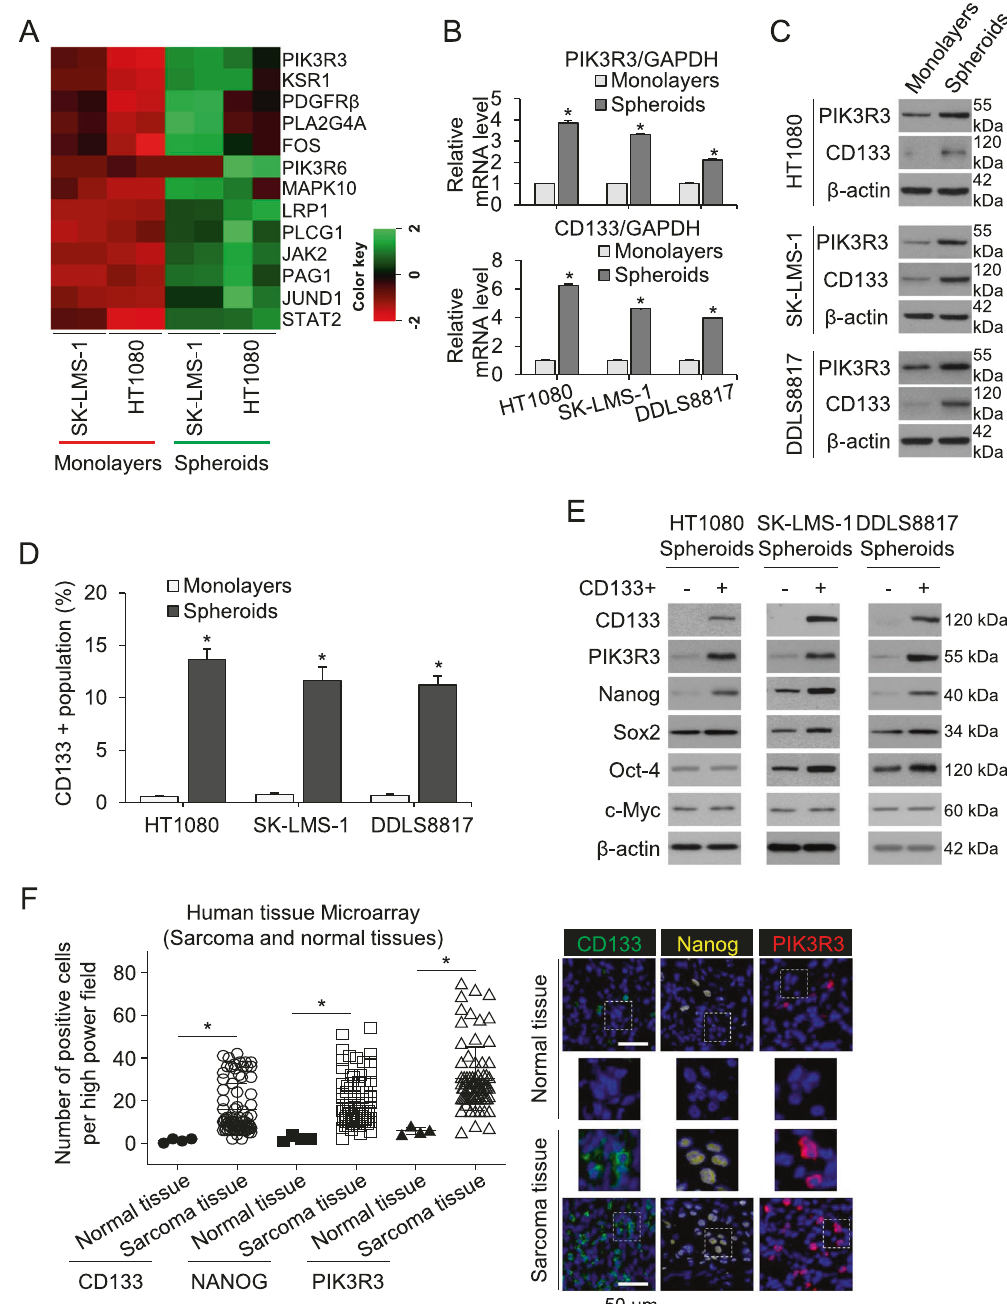
Fig. 1 PIK3R3 and Nanog are upregulated in sarcoma CSCs and human sarcomas. A Heat map of expression of survival signaling-related genes in two sarcoma cell lines cultured as spheroids vs. monolayers as measured by RNA sequencing. Each sample was run in duplicate. Real- time RT-PCR ( B ) and ( C ) Western blot ( C ) for PIK3R3 and CD133 in three sarcoma cell lines grown as monolayers or as spheroids. D Proportion of CD133 + cells as measured by fl uorescence-activated cell sorting (FACS) analysis in sarcoma cells grown as monolayers or as spheroids. E Western blot for PIK3R3, CD133, Nanog, Sox2, Oct-4 and c-Myc in CD133 + and CD133 – populations of sarcoma cell lines cultured as spheroids. F Graph and immunostaining of commercially available tissue array slide containing 79 human sarcomas and 4 human normal tissues for CD133, Nanog, and PIK3R3. β -actin is the loading control. * p < 0.05 compared to spheroid vs. monolayer cells (Fig. 1B). Upregulation of PIK3R3 and regulatory subunit 3 (PIK3R3) was the most highly upregulated CD133 in sarcoma cells grown as spheroids vs. monolayers was survival signaling-related gene in spheroid (CSC-enriched) vs. also con fi rmed at the protein level using Western blot analysis monolayer cells (Fig. 1A). Upregulation of PIK3R3 and the cancer (Fig. 1C). To enrich for CSCs using an alternative approach, we stem cell marker CD133 in spheroid cells was veri fi ed using sorted CD133 + cells from the three sarcoma cell lines, which quantitative real-time PCR (qRT-PCR) in HT1080 and SK-LMS-1 cells composed 10 – 13% of the population when grown as spheroids as as well as DDLS8817 dedifferentiated liposarcoma cells, which measured by fl ow cytometry (Fig. 1D, Supplementary Fig. S1A). showed 3.9 – 6.2 and 2.1 – 3.8-fold higher expression, respectively, in